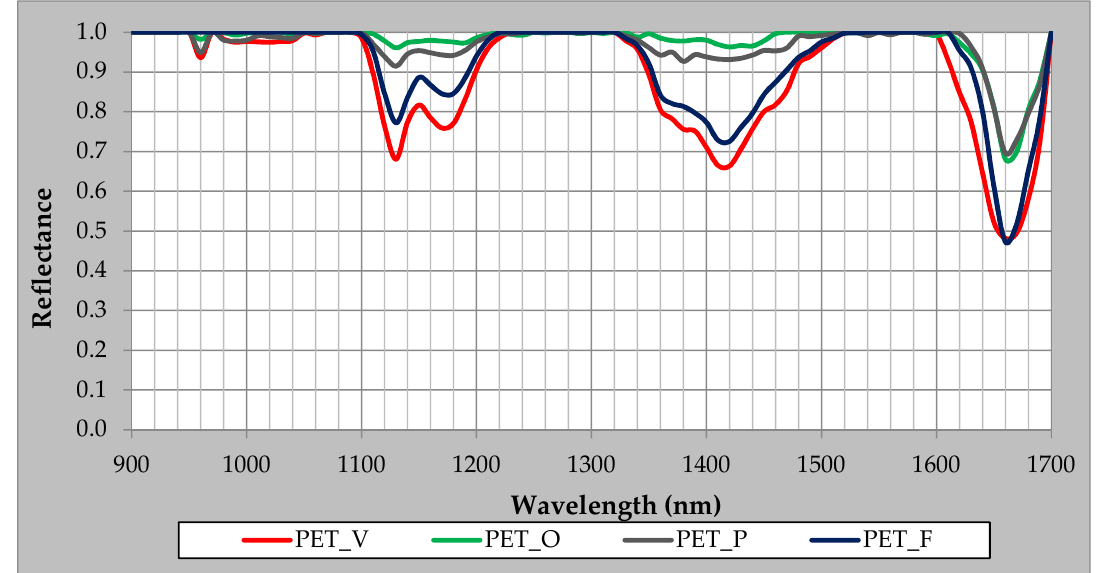
Figure 5. Spectral signatures of PET samples in the NIR region, detected with linear spectrometer, processed with the method Continuum Removal (CR).